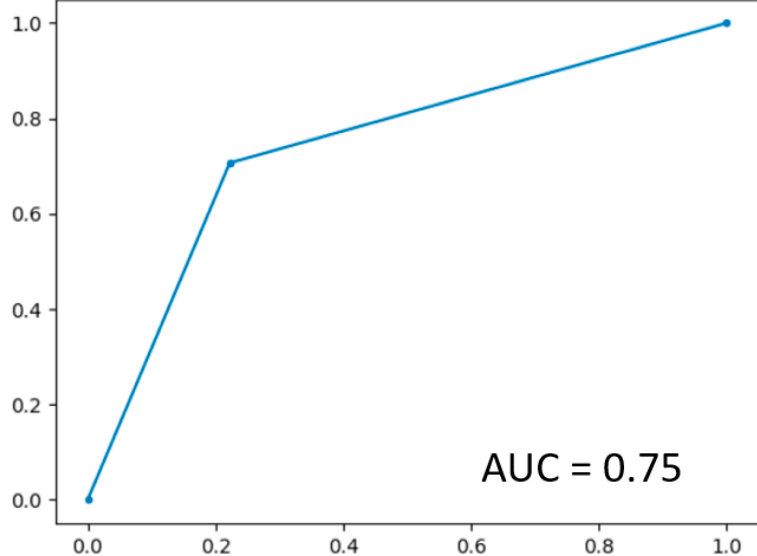
Figure 3. ROC curve on the dataset.